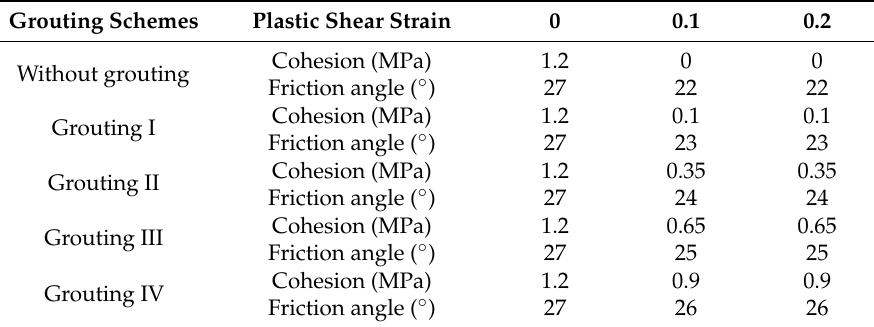
Table 3. Residual cohesion and friction angle of floor strata after grouting.